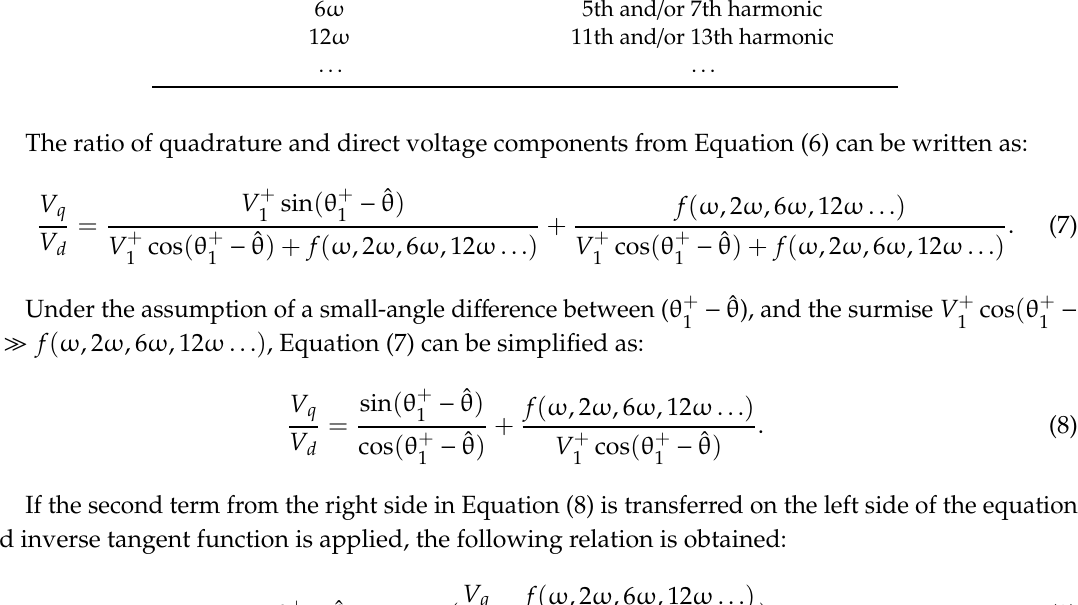
Table 1. Origin of oscillations in synchronous reference frame voltages in the quasi-locked state. Oscillation Frequency ( dq ) Origin ( abc ) ω DC o ff set 2 ω Fundamental voltage unbalance 6 ω 5th and / or 7th harmonic 12 ω 11th and / or 13th harmonic ...